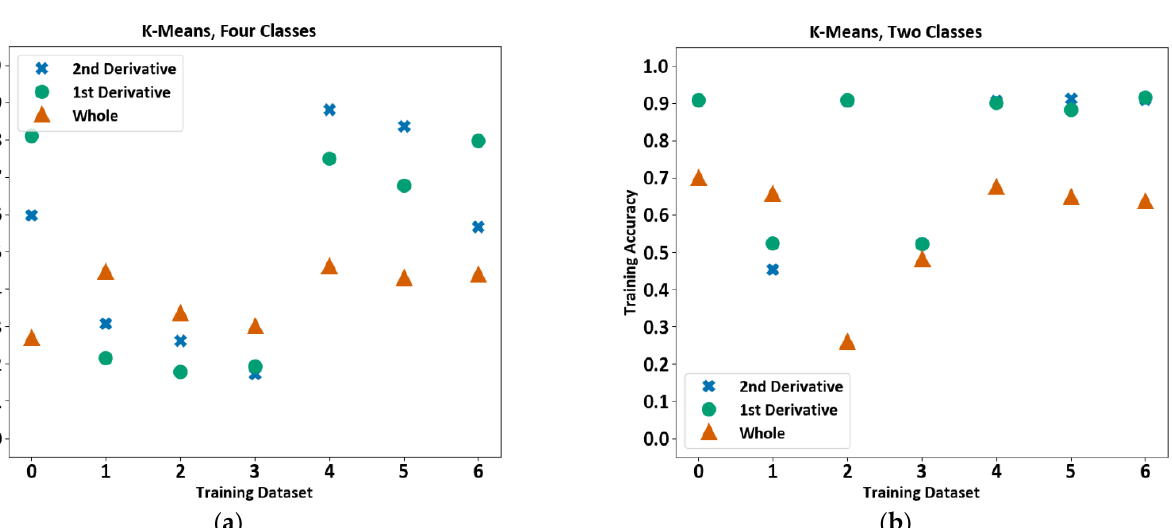
Figure 7. Example of material masks constructed and source image.